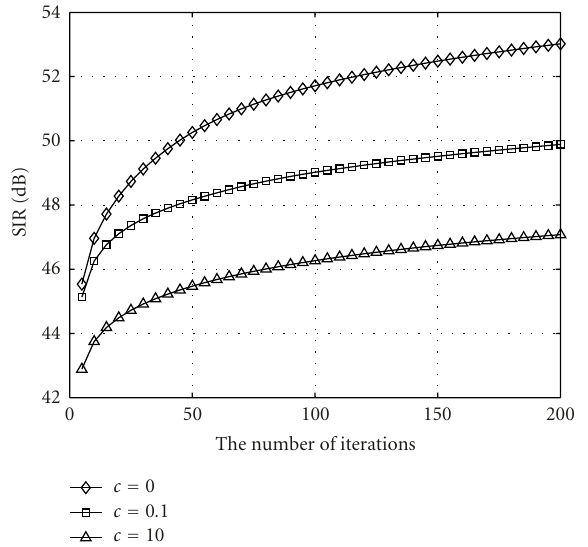
Figure 10: SIR versus the number of iterations.